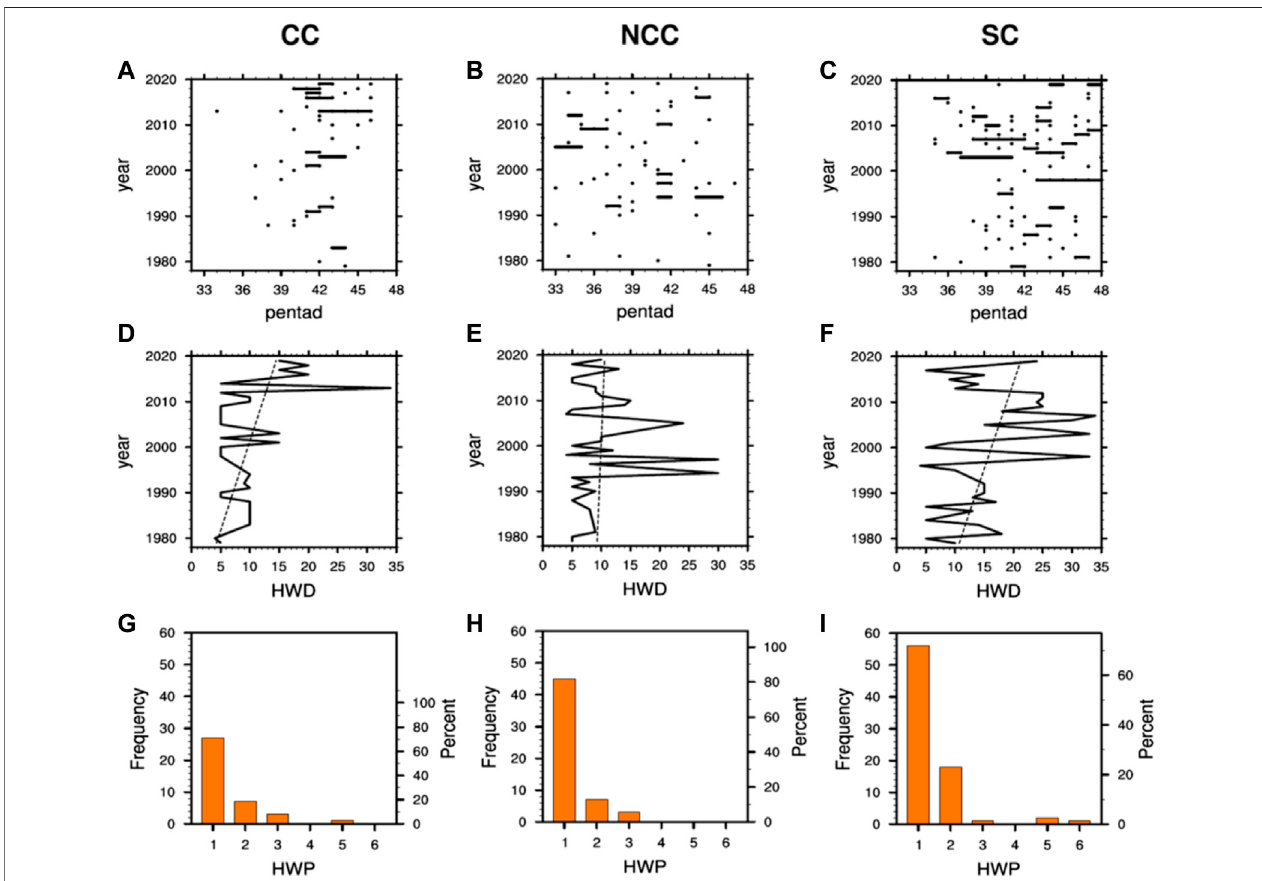
FIGURE5| InterannualvariationsofoccurredtimeofindividualRPHW (A – C) andHWD (D – F) ,andfrequencyofHWP (G – I) .In (A – C) ,onedotindicatesoneRPHW, and the black line links the consecutive RPHW. In (D – F) , the straight line indicates the corresponding linear trend.